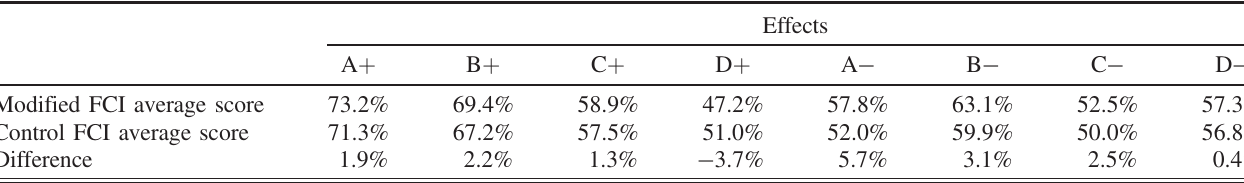
TABLE VIII. Average scores are for a selection of 3 to 6 questions present on the FCI or one of the two modified versions of the FCI in data set 4. The modified versions of the FCI had the options changed for many of their questions to elicit testwiseness effects that were intended to either improve or diminish student